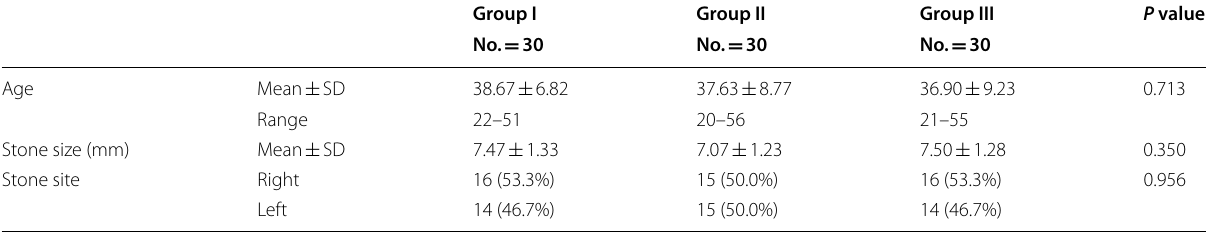
Table 1 Comparison between groups according to demographic data